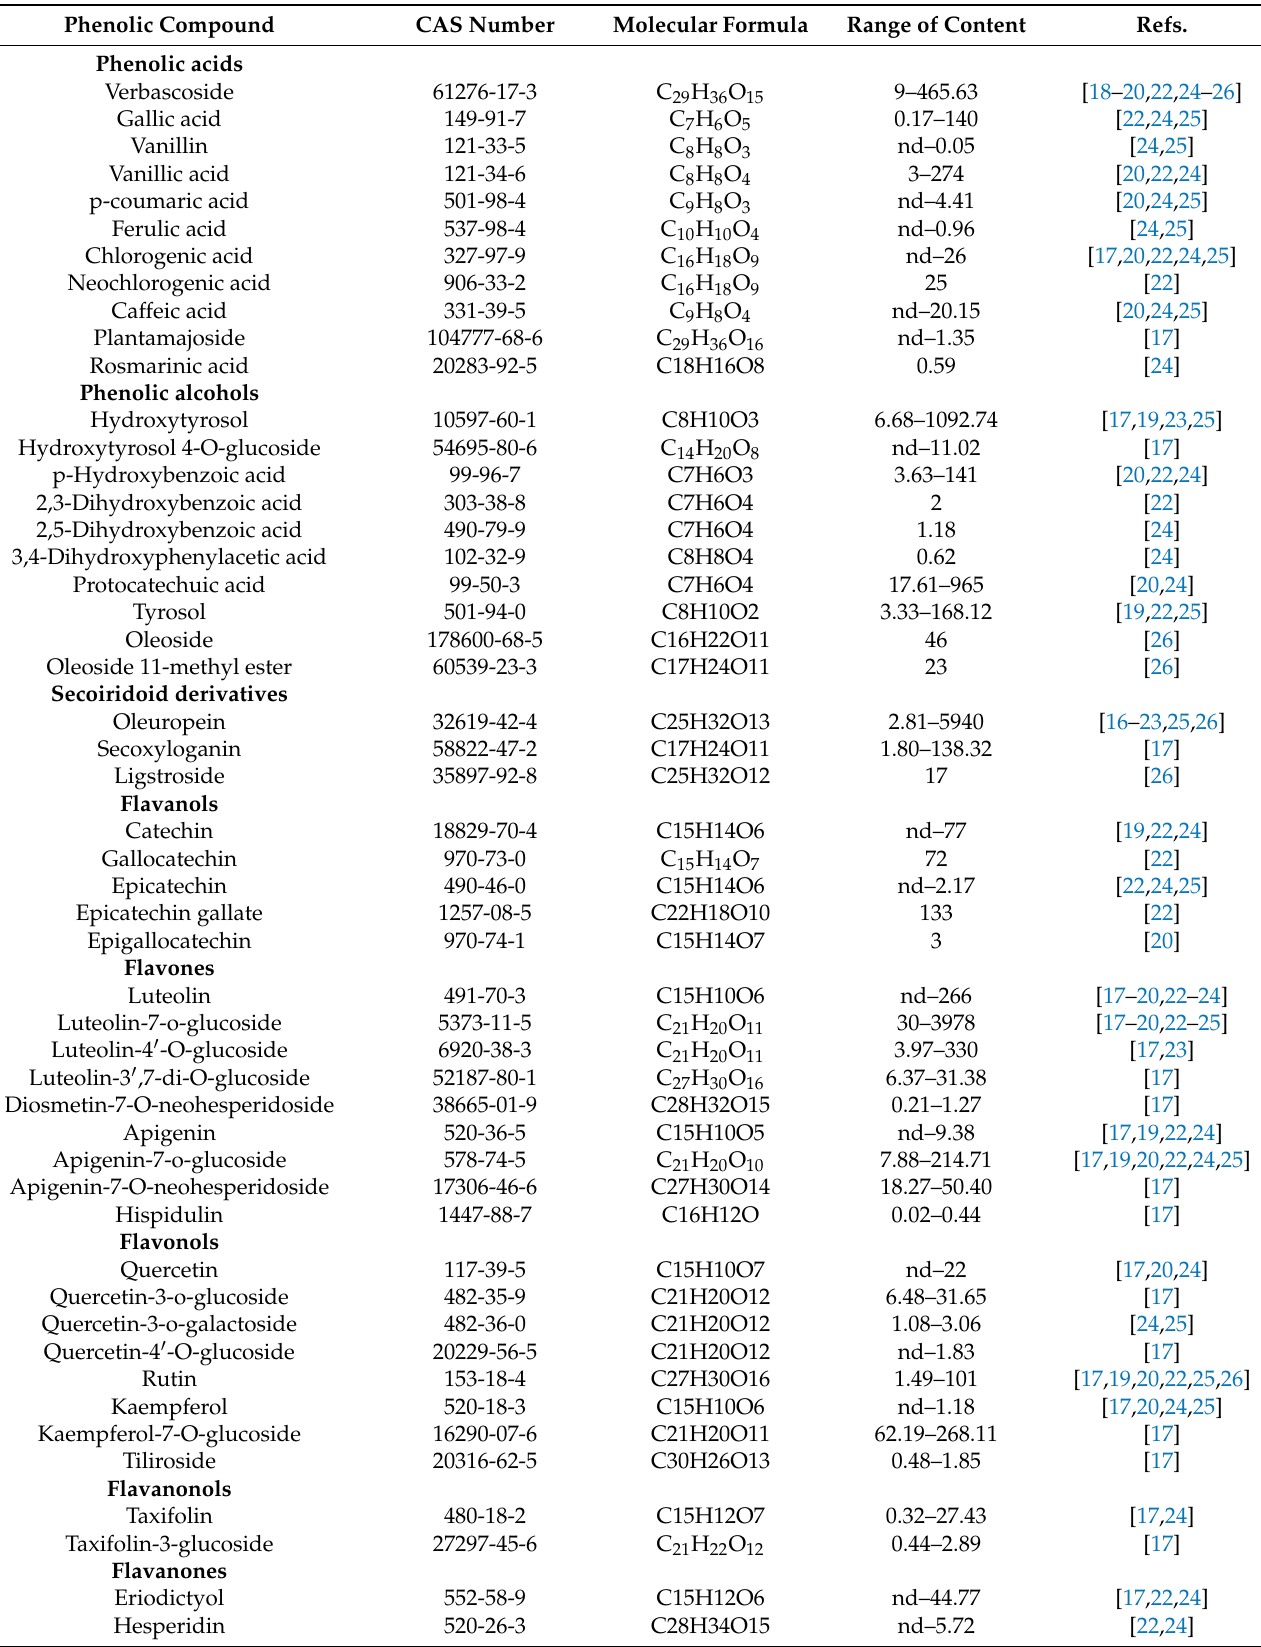
Table 1. Phytochemical characterization of olive